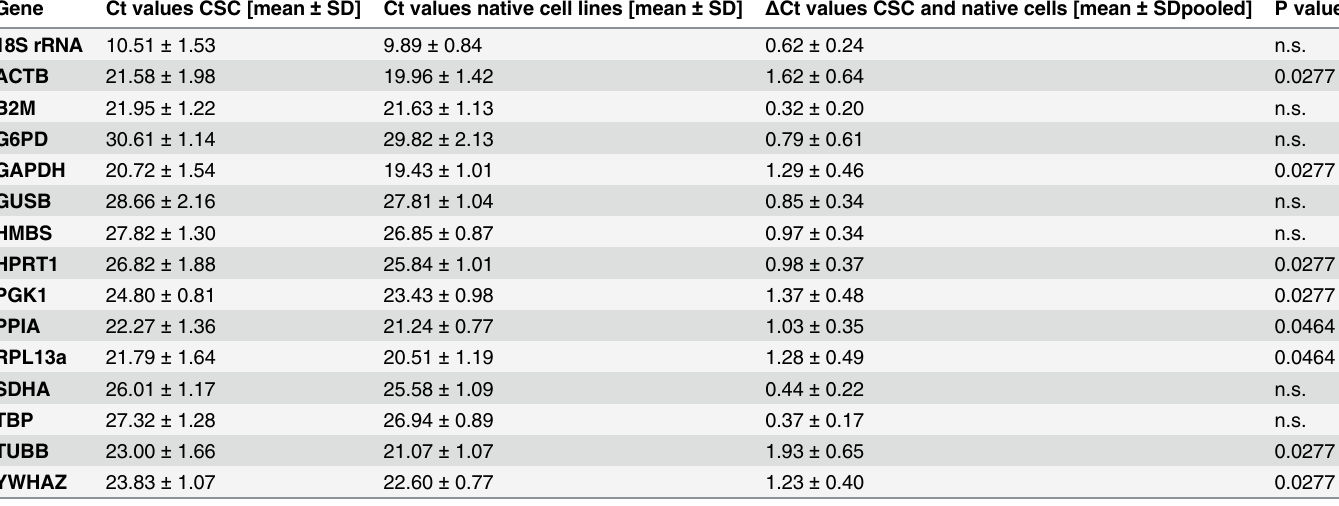
Table 3. Ct values of candidate HKG genes in CSC and native cell